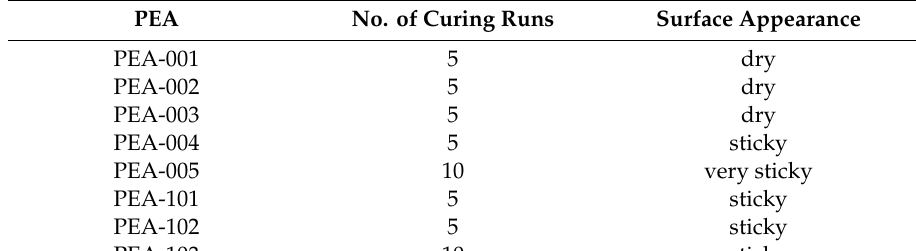
Figure 6. FT-IR-spectra of PEA-002 before and after UV-curing.